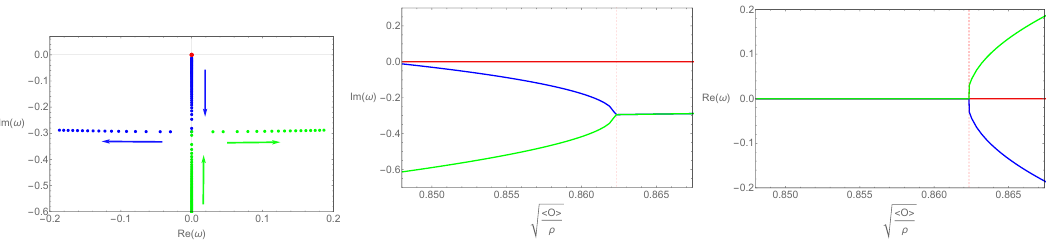
Figure 12 . The dynamics of the amplitude mode in the 1st order phase transition in the broken phase. The blue line is the trajectory of the amplitude mode shown in the middle plot of figure 3. The green line is an additional non-hydrodynamic mode which originally sits on the negative axis. The red line is the Goldstone mode. The location of the collision is indicated with a dashed line in the middle and right panels. The left panel shows the dynamics in the complex frequency plane, making clear the collision between the blue and green